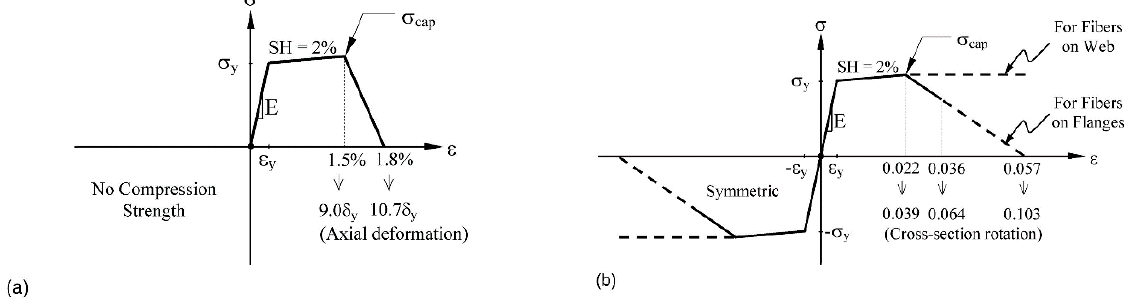
Figure 4. Degradation models by R. Purba and M. Bruneau [29]; ( a ) strips; ( b ) boundary